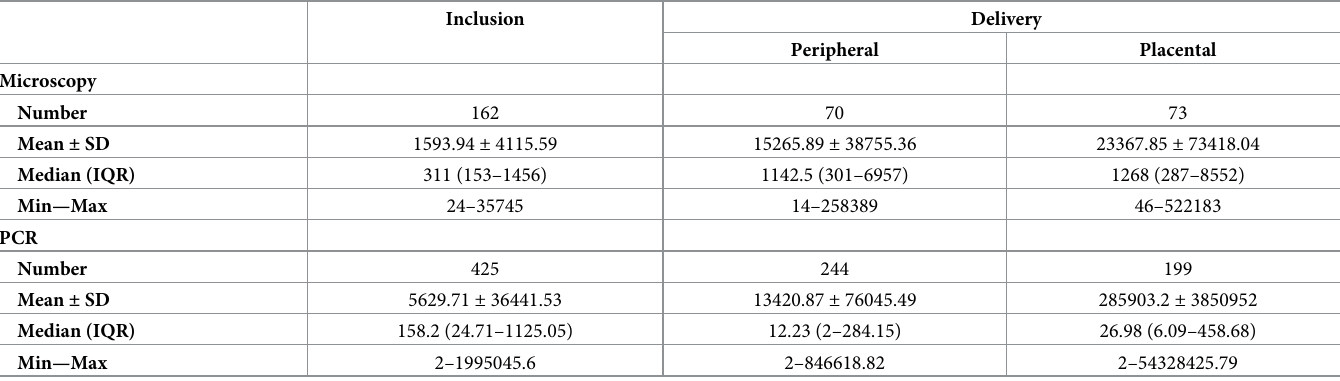
Table 1. Parasite load of infections detected by microscopy and PCR.